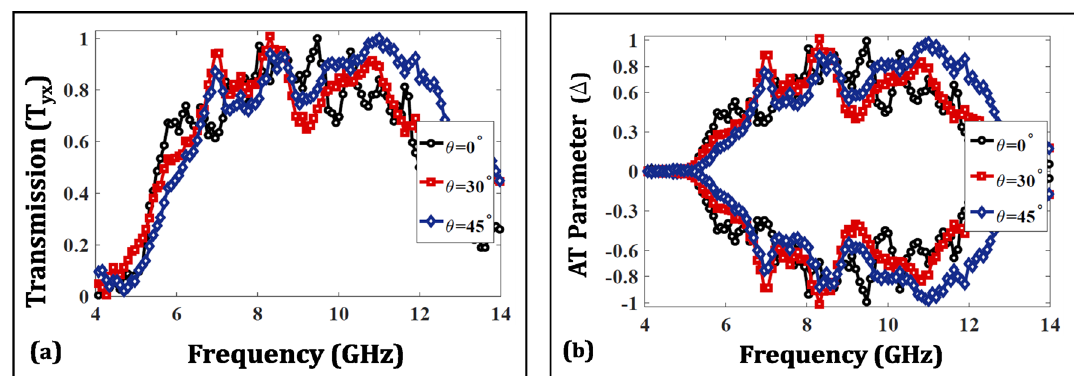
Figure 16. Measured results ( a ) Transmission parameter ( T yx ) ( b ) AT